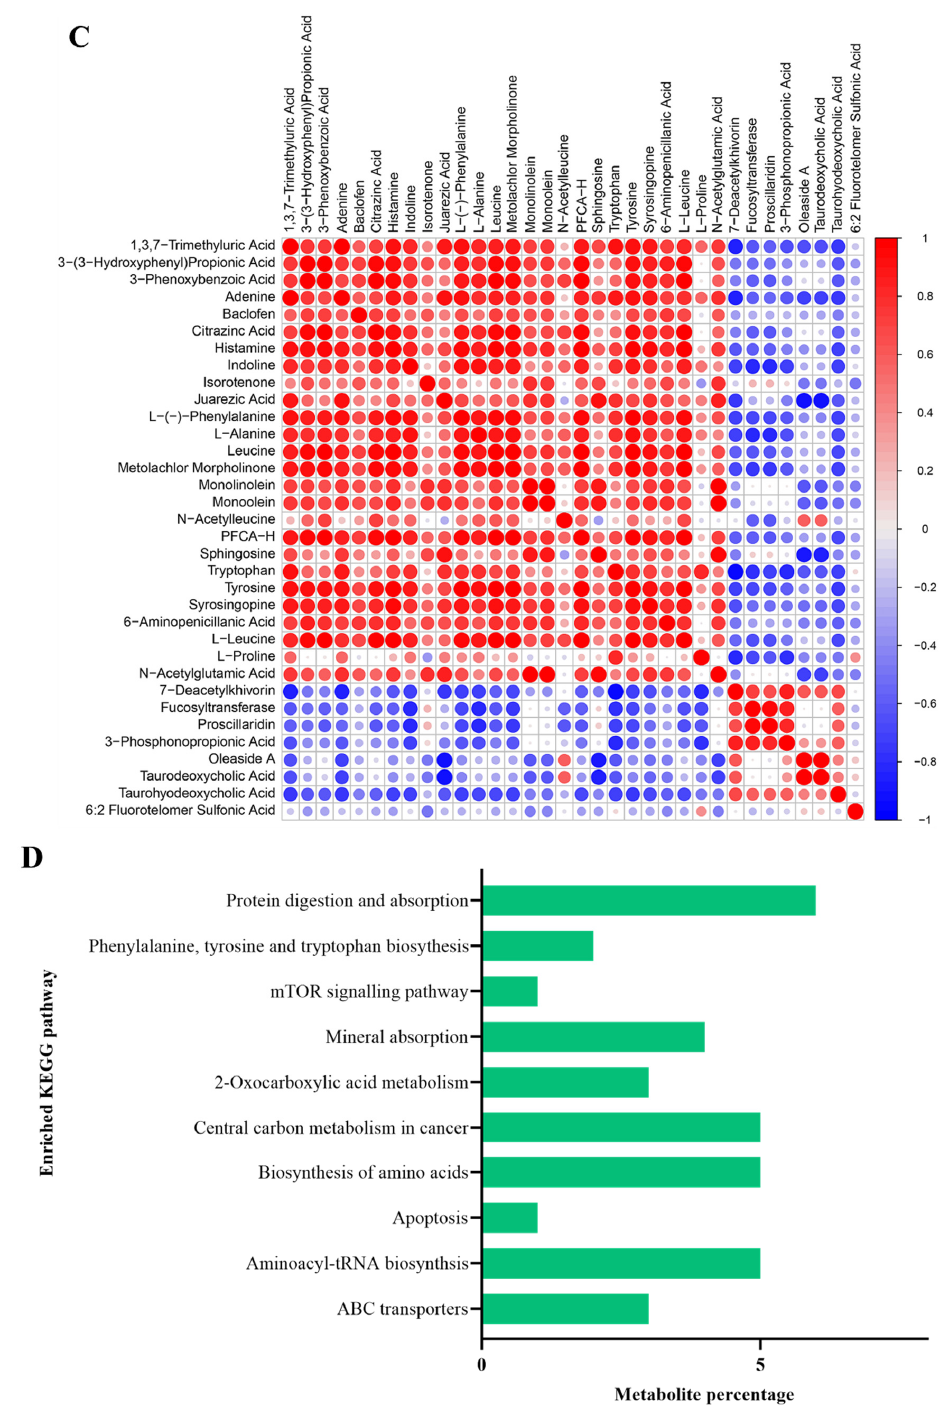
Figure 5. Effect of SCS on gut metabolites in tumor-bearing mice. Principal component analysis (PCA) was used to evaluate the differences of gut metabolite composition in each group ( A ). Heat map of significantly altered fecal metabolites ( B ), and the Pearson correlation coefficient value R is between − 1 and +1. The correlation coefficient R between metabolites is expressed in color and circle, where R > 0 indicates positive correlation and red indicates positive correlation. R < 0 indicates negative correlation, expressed in blue; The larger the circle and the darker the color, the stronger the correlation. Correlation Clustering matrix of significant difference metabolites in each group ( C ). Enriched KEGG pathway analysis for High group vs. Model group ( D